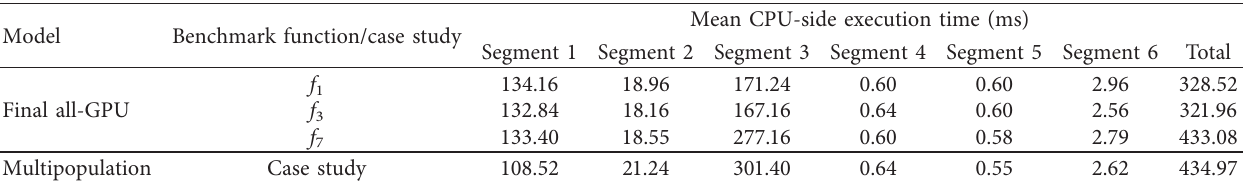
Table 7: Mean CPU-side execution time results of the final all-GPU model on some benchmark functions and the multipopulation model on the case